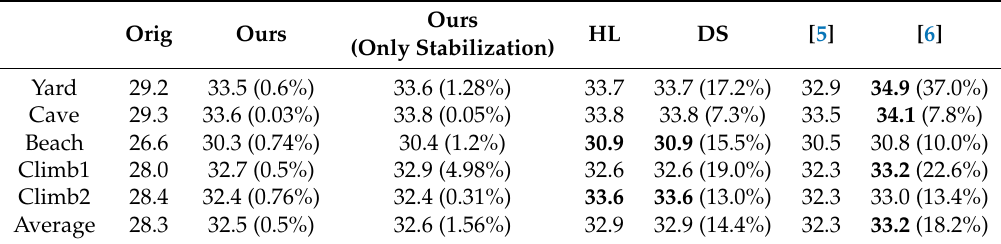
Table 4. Original inter-frame transformation fidelity (ITF)